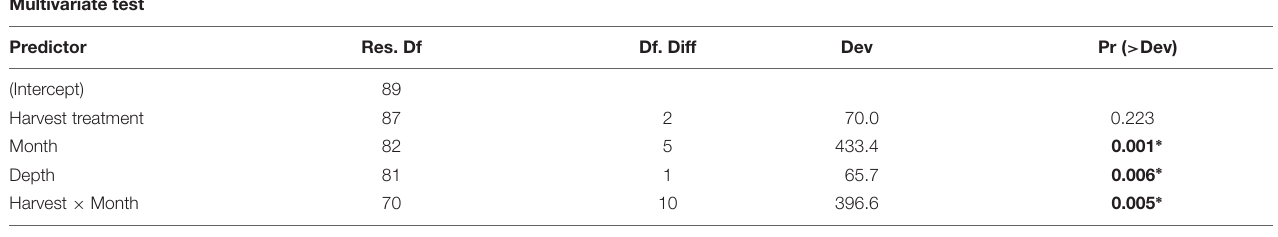
TABLE 2 | Results of multivariate test of change in assemblage structure followed by individual GLM results identifying taxa with significant or large effects. Multivariate